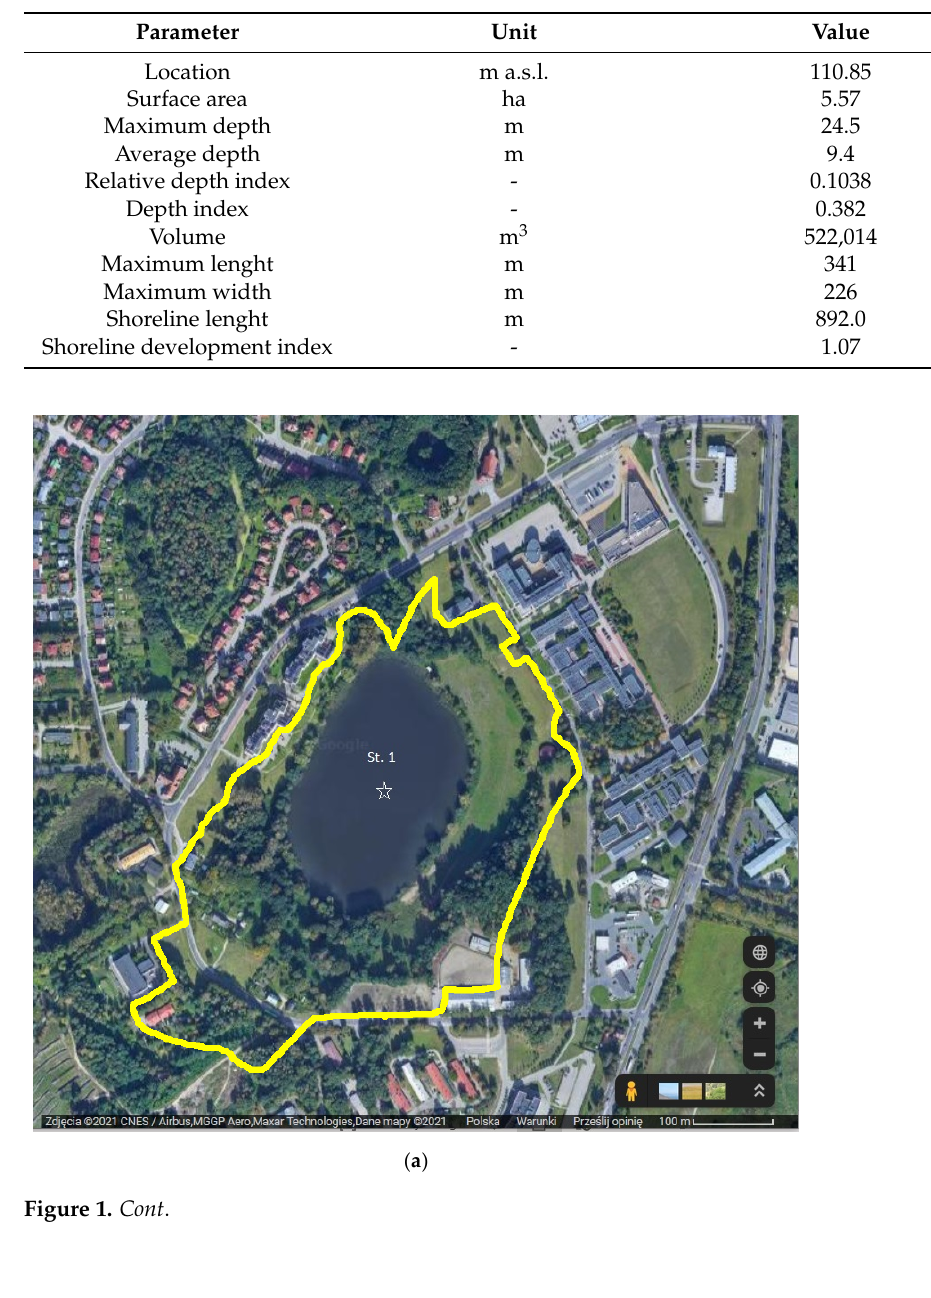
Table 1. Basic morphometrical parameters of Starodworskie Lake [4].